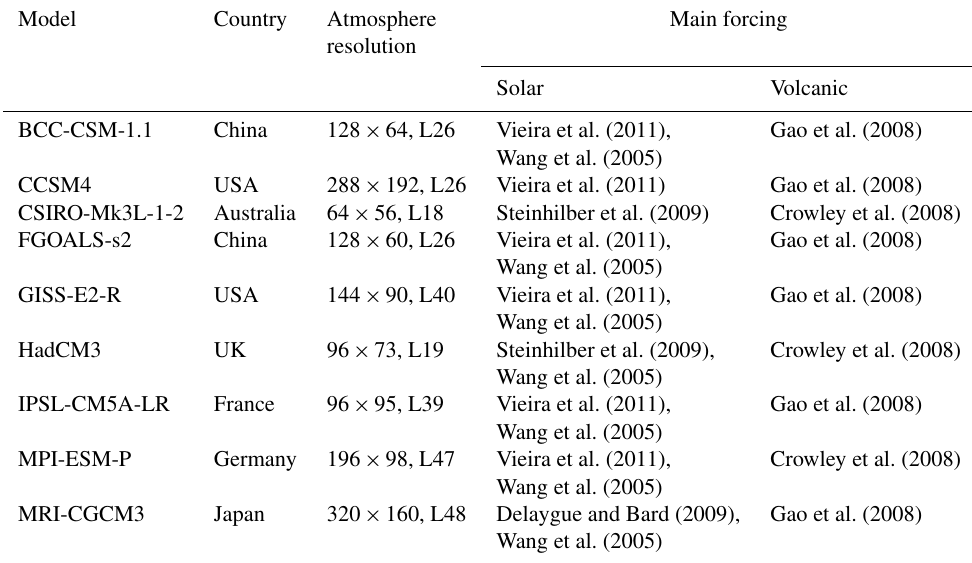
Table 1. PMIP3 model simulation information and their main forcing. Model